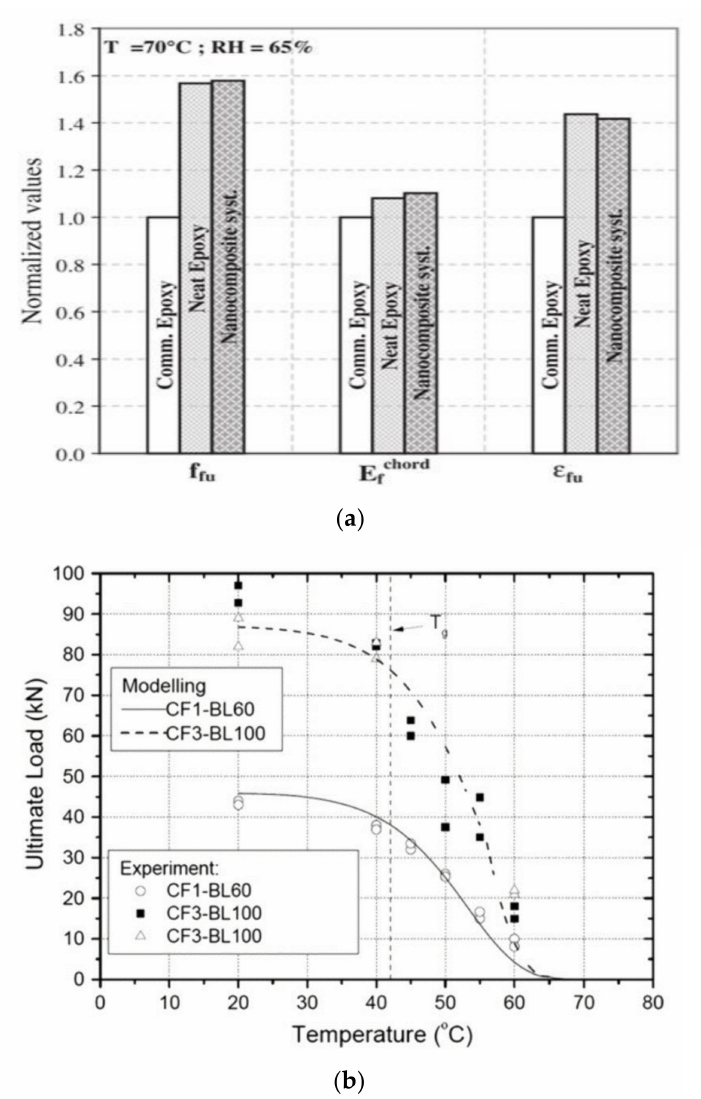
Figure 6. ( a ) Normalised strength (f fu ), Young’s modulus (E f chord) and ultimate strain ( ε fu ) of samples tested at 70 ◦ C and 65% relative humidity [71]; used with permission from constructions and building materials, Elsevier, 2021. ( b ) Experimental and modelled bond strengths of normal modulus CFRP double lap joints vs, temperature [75], where the CF3-BL100 curve with the triangle marker is taken from [74]; used with permission from Composite Structures, Elsevier,